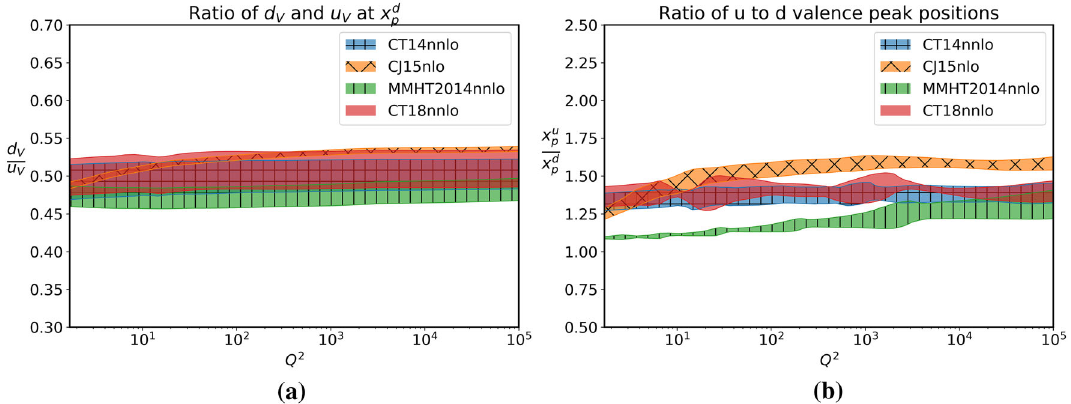
Fig. 7 a The Q 2 dependence of the ratio of d- to u-valence quark distributions at the peak position of h ( x , t ) distribution for d quark. b The Q 2 dependenceoftheratioofthepeakpositionsofthed-andu-valencequark h ( x , t ) distributions.DifferentPDFsetsareusedfromRefs.